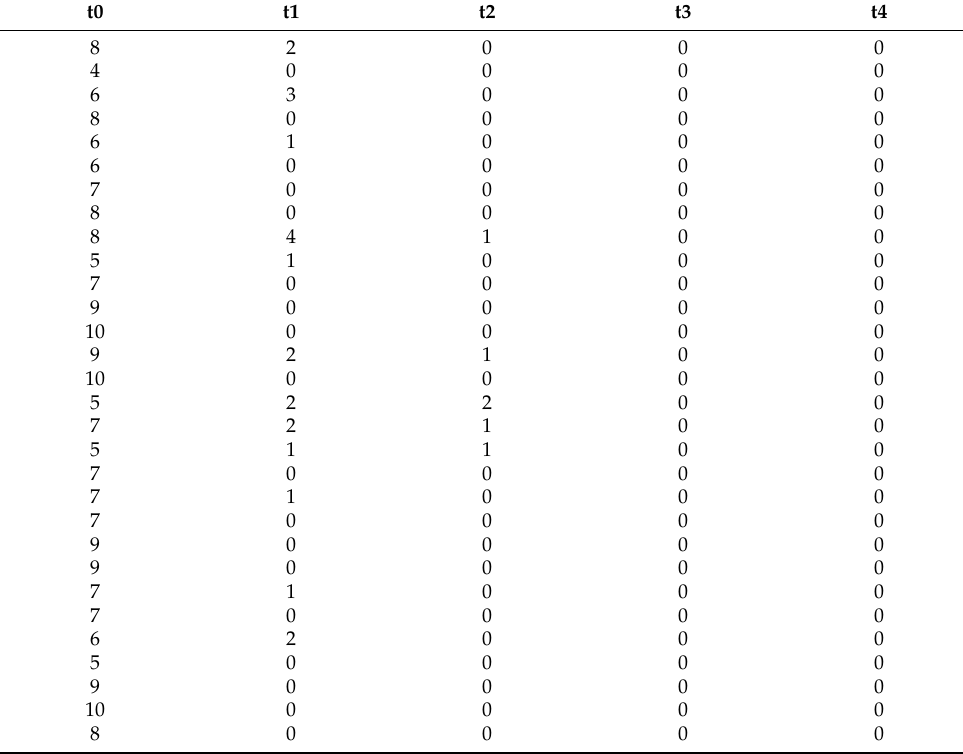
Table 2. Aesthetic dissatisfaction at timepoints (Visual Analogue